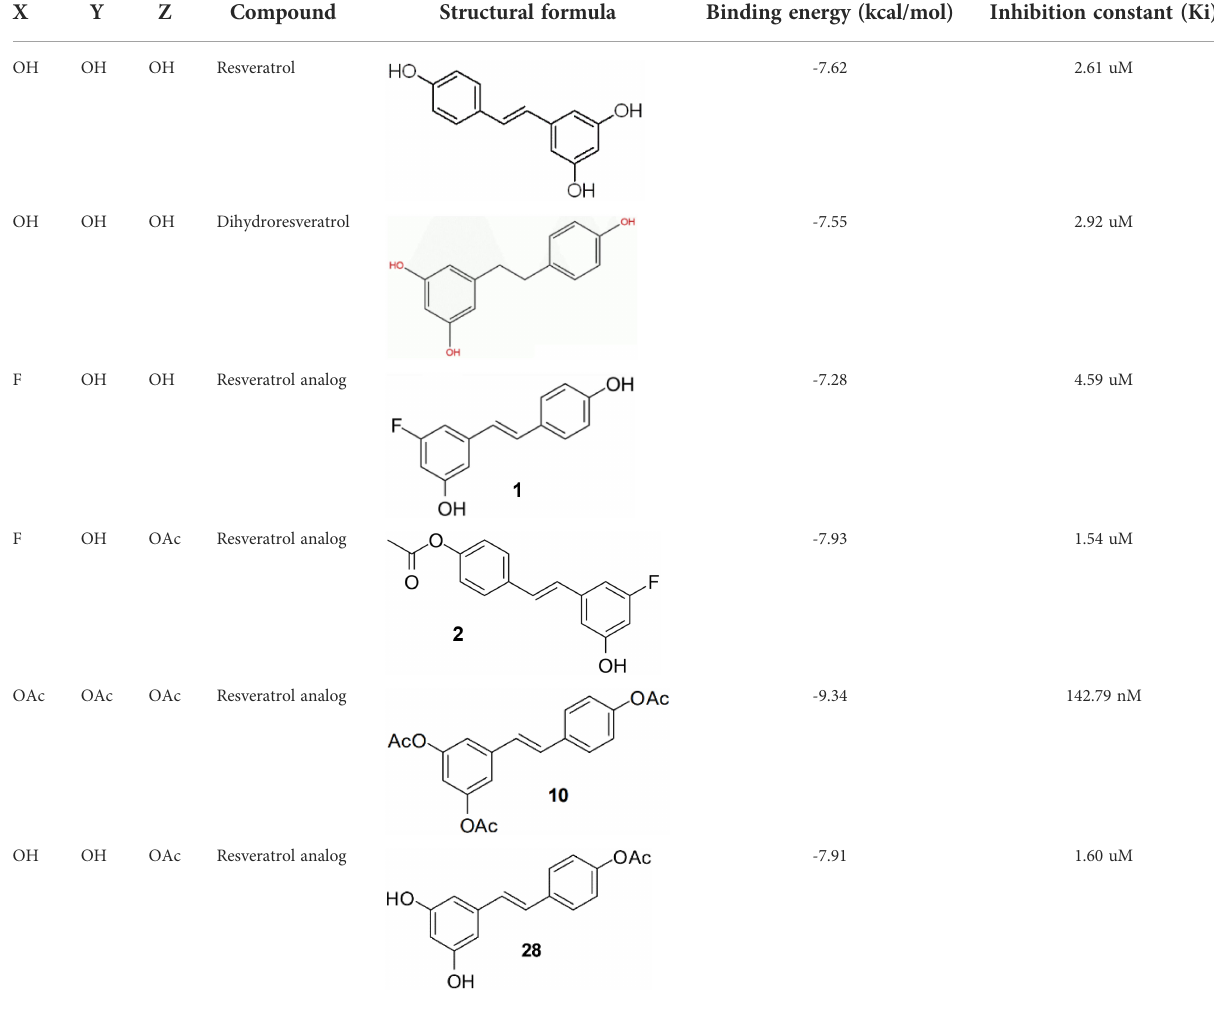
TABLE 2 Molecular docking study of the Resveratrol and analogs with SIRTs (PDB: 5D7N). Compound Structural formula Binding energy (kcal/mol) Inhibition constant (Ki)